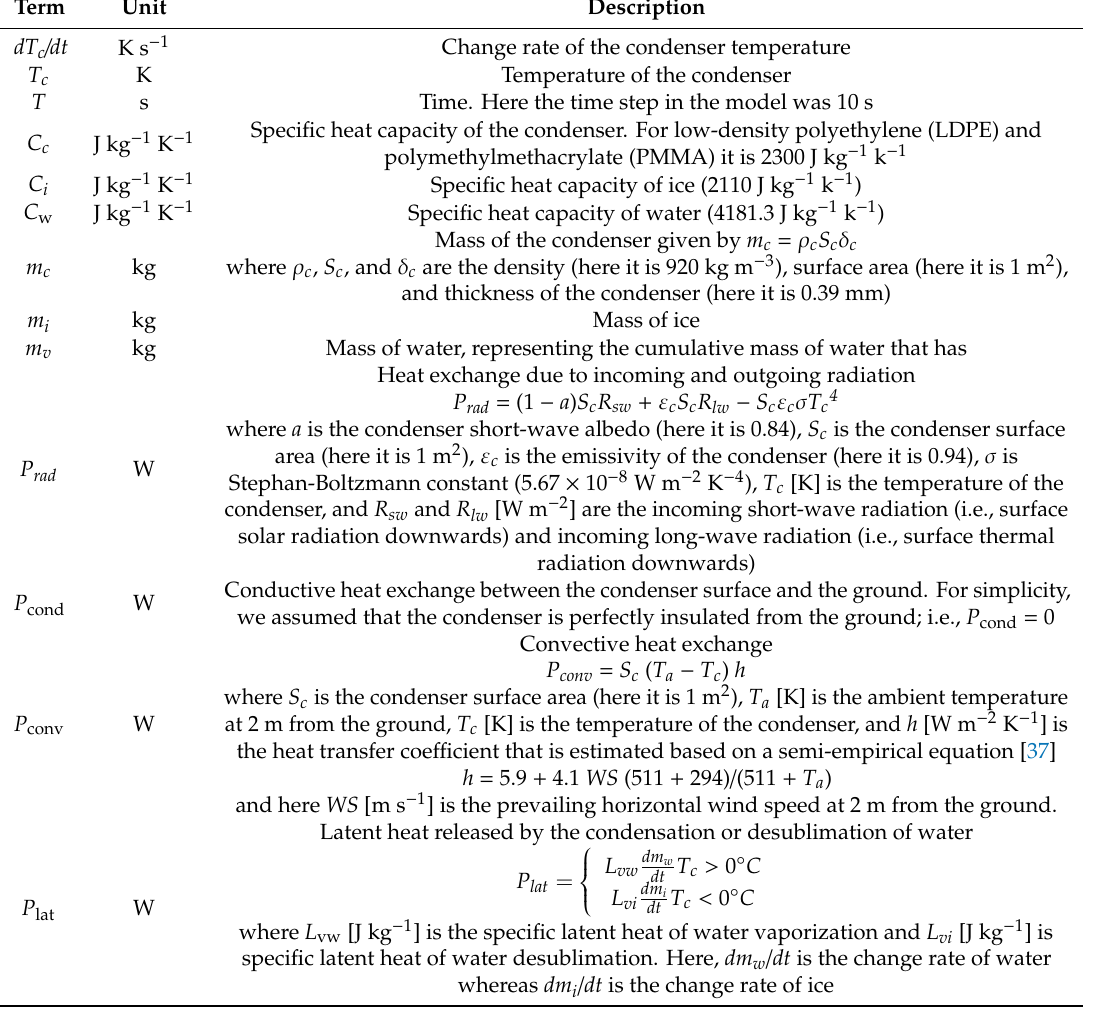
Table A1. Description of the dew formation model by listing the terms in Equation (A1). Term Unit